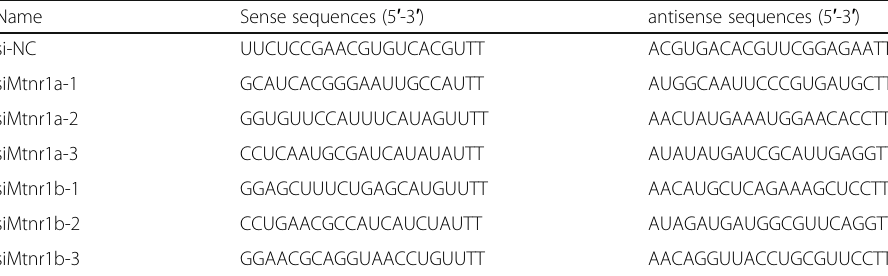
Table 2 Sequences of small interfering RNA